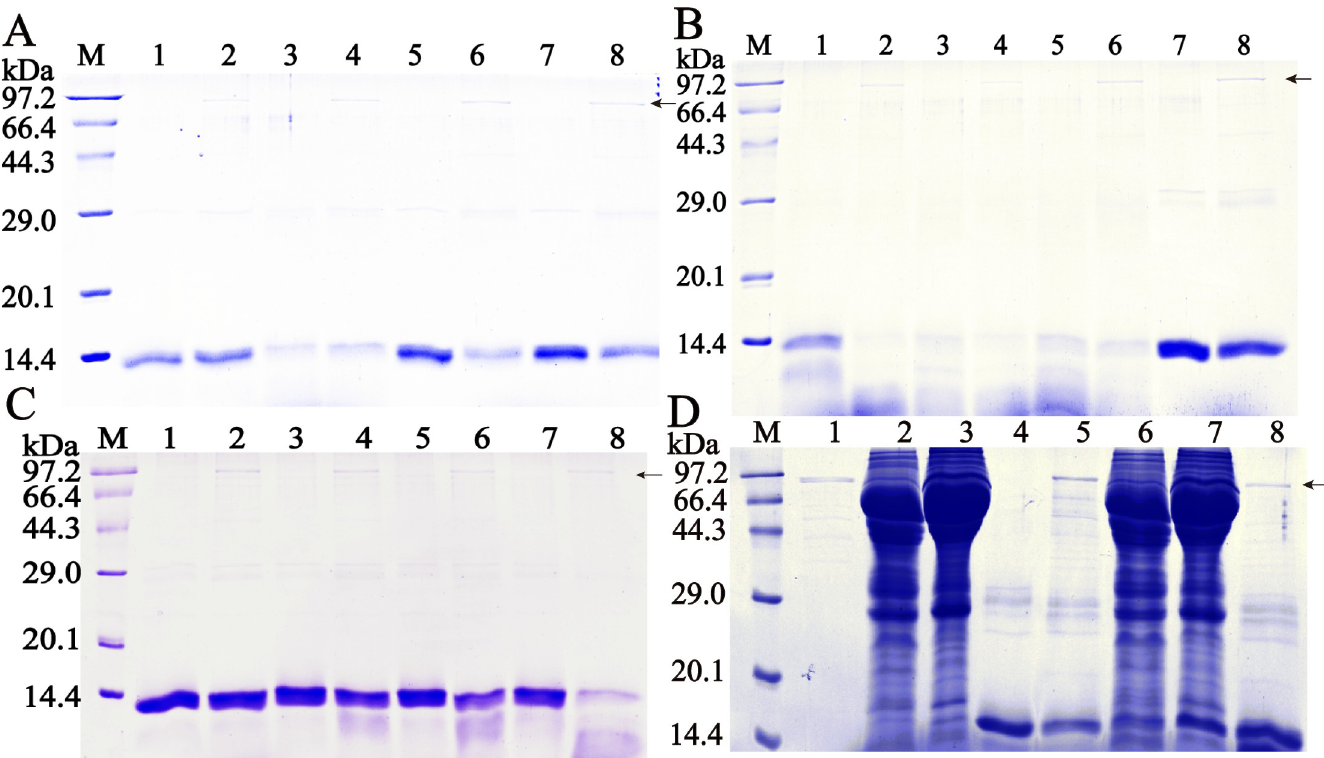
Fig 4. Hemoglobin degradation. A-B Hydrolysis of Hb by rTsASP2 at different pH values. A : human Hb; B : mouse Hb; M: protein marker; lanes 1, 3, 5 and 7: Hb alone; lanes 2, 4, 6 and 8: Hb+ rTsASP2; lanes 1 and 2: pH 2.5; lanes 3 and 4: pH 3.5; lanes 5 and 6: pH 4.5; lanes 7 and 8: pH 5.5. C: Hydrolysis efficiency effect of rTsASP2 on mouse Hb (pH 2.5). M: protein marker; lanes 1, 3, 5 and 7: Hb alone; lanes 2, 4, 6 and 8: Hb+ rTsASP2; lanes 1 and 2: 5 min; lanes 3 and 4: 30 min; lanes 5 and 6: 90 min; lanes 7 and 8: 4 h . D: Inhibition effect of anti-rTsASP2 serum and pepstatin A on rTsASP2 hydrolysis of mouse Hb (pH 2.5). M: protein marker; lane 1: rTsASP2; lane 2: anti-rTsASP2 serum; lane 3: heated anti-rTsASP2 serum; lane 4: Hb; lane 5: Hb +rTsASP2; lane 6: anti-rTsASP2 serum pre-incubated with rTsASP2 +Hb; lane 7: heated anti-rTsASP2 serum pre-incubated with rTsASP2+ Hb; lane 8: pepstatin A pre-incubated with rTsASP2 + Hb. The arrow represents the band of rTsASP2 (86.4